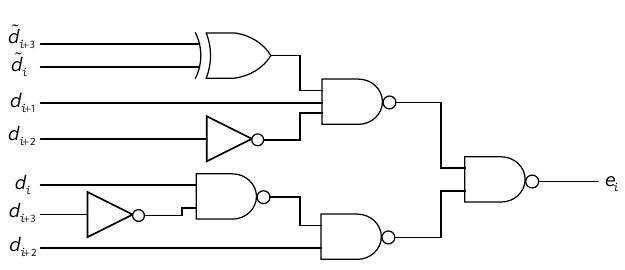
Figure 4: The proposed subfield inverter block over GF (2 4 ) to generate e i , 0 ≤ i ≤ 3 , for E = P 3 e i β 2 i = D − 1 , where D = P 3 d i β 2 i and the additions in the input indices are i =0 i =0 performed modulo 4. Note that ˜ d i , 0 ≤ i ≤ 3 are the signals from Figure 3 that generate d i = c 4 + ˜ d i